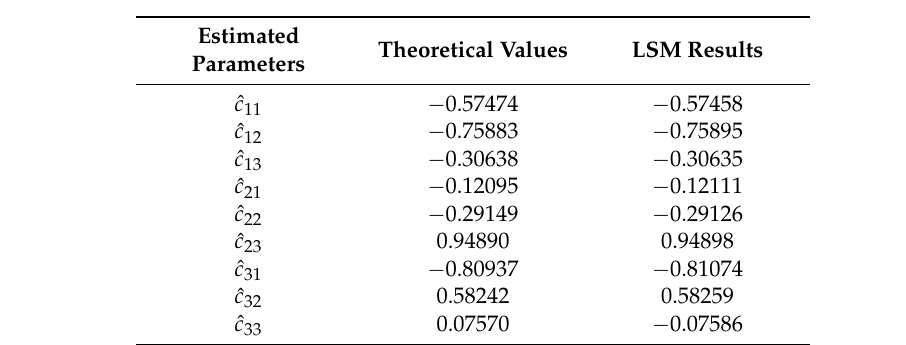
Figure 7. On-orbit calibration results of EKF. Table 3. Calibration results of LSM.